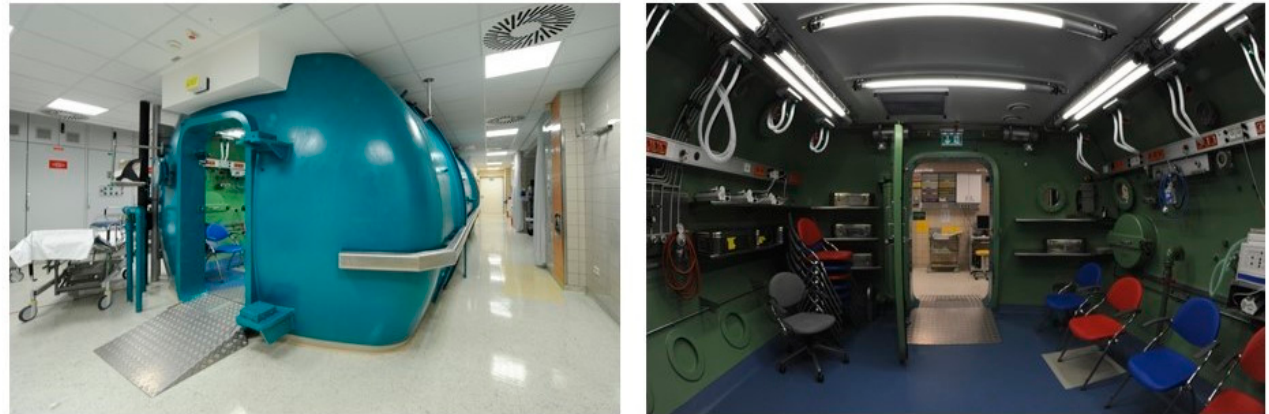
Figure 1. External and internal view of the hyperbaric chamber located at the Division of Thoracic and Hyperbaric Surgery, Department of Surgery, Medical University of Graz, Austria. Clearly visible are the white lines for the oxygen supply during the hyperbaric treatment in the internal space of the chamber. (Author´s pictures).